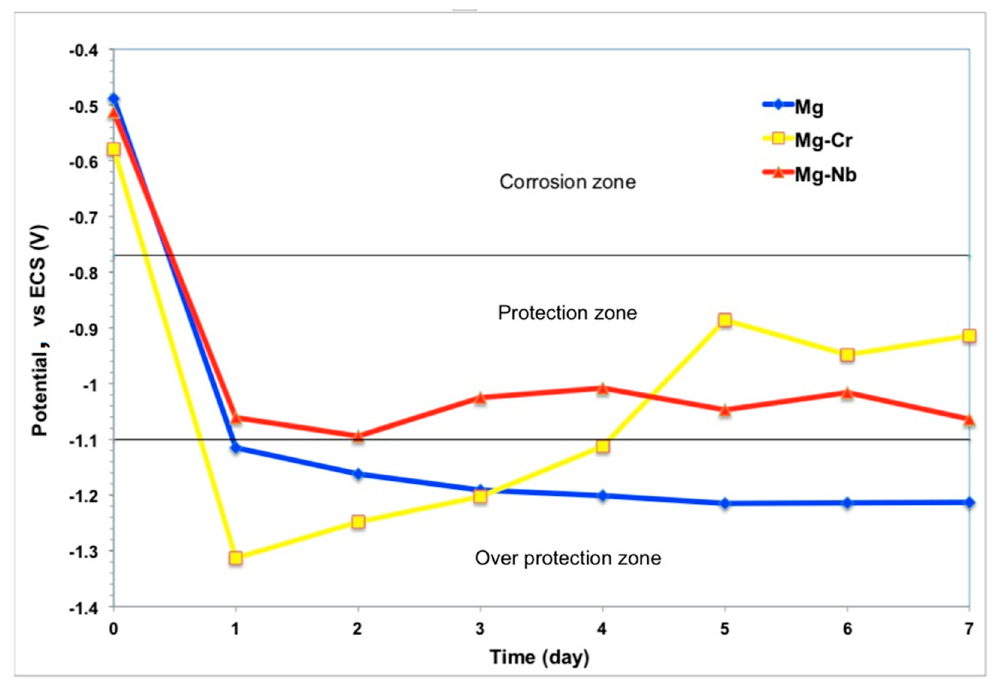
Figure 13. Cathodic polarization potential for the X52 steel in the function of immersion time in seawater for the three anodes.